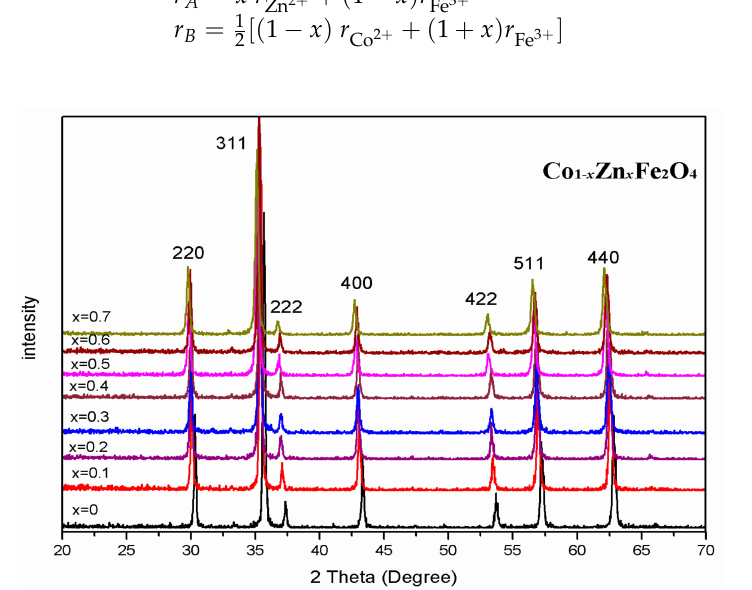
Figure 1. Room-temperature XRD patterns of Co 1 − x Zn x Fe 2 O 4 calcined at 800 ◦